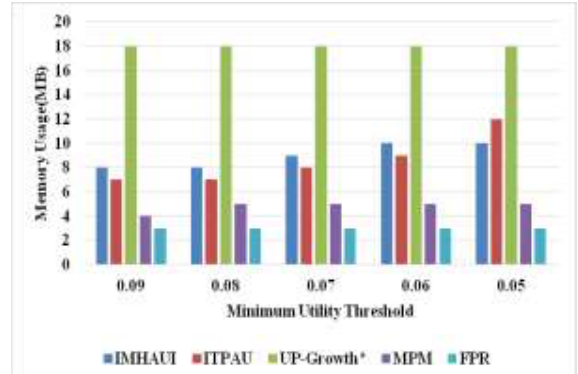
Figure 8. Breast_Cancer_Wisconsin Memory Usage